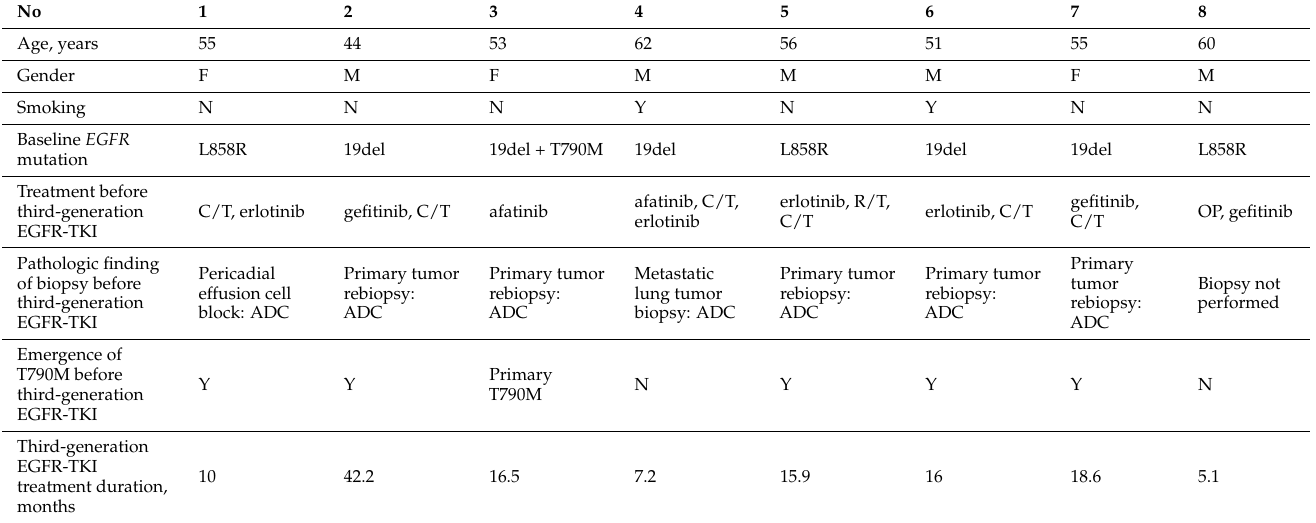
Table 2. Clinical data and outcomes of lung cancer patients developing histological transformation after the third-generation EGFR-TKI treatment. F, female; M, male; L858R, Leu858Arg; 19del; exon 19 deletion; T790M, Thr790Met; C/T, chemotherapy; R/T, radiotherapy; OP, operation; ADC, adenocar- cinoma; SqCC, squamous cell carcinoma; LCNEC, large cell neuroendocrine carcinoma; SCLC,